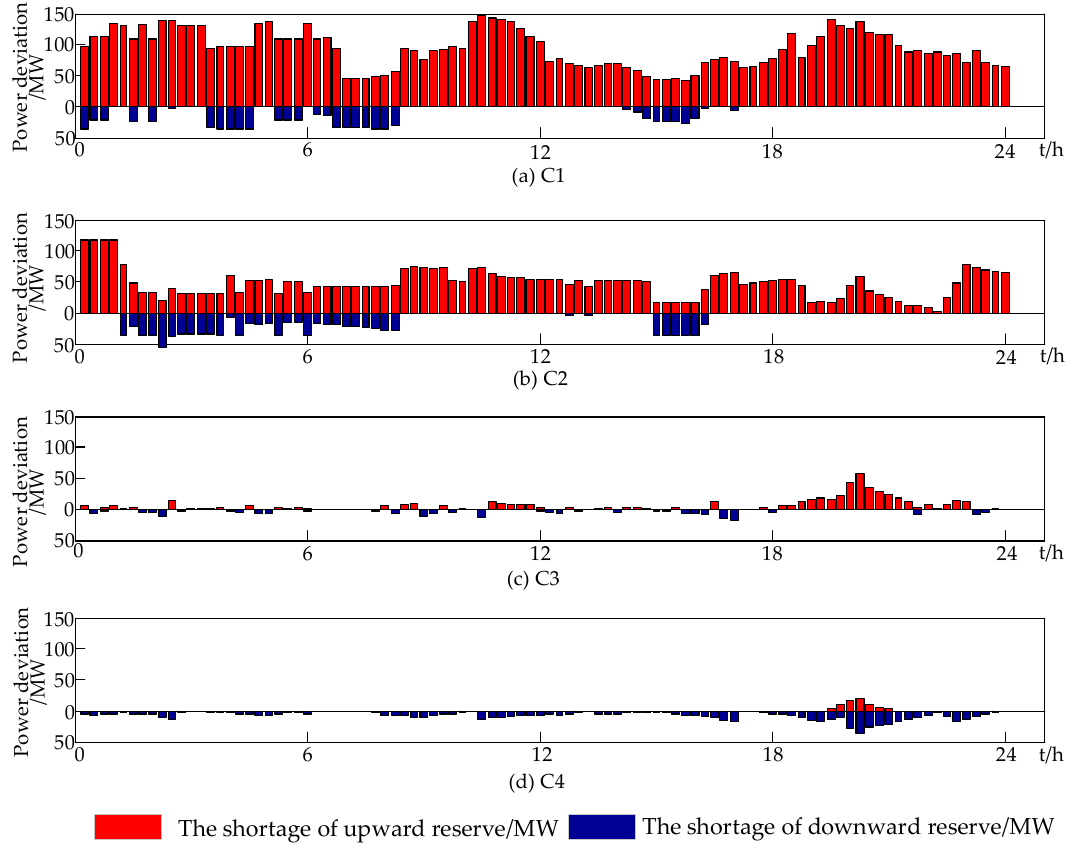
Figure 9. The shortage of reserve capacities for the different cases presented.